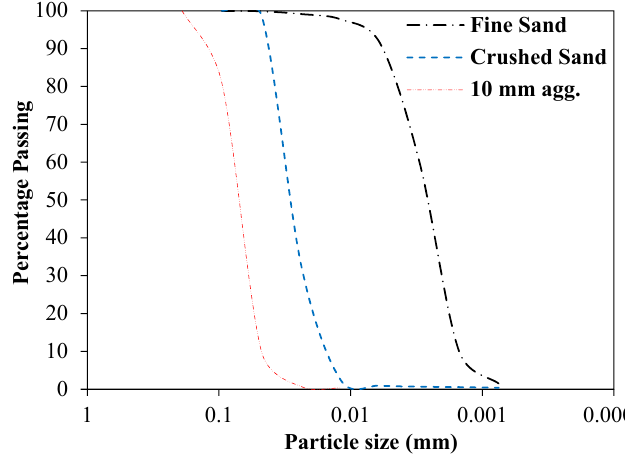
Figure 1. Distribution of particle size for fine and coarse aggregate (FA / CA).